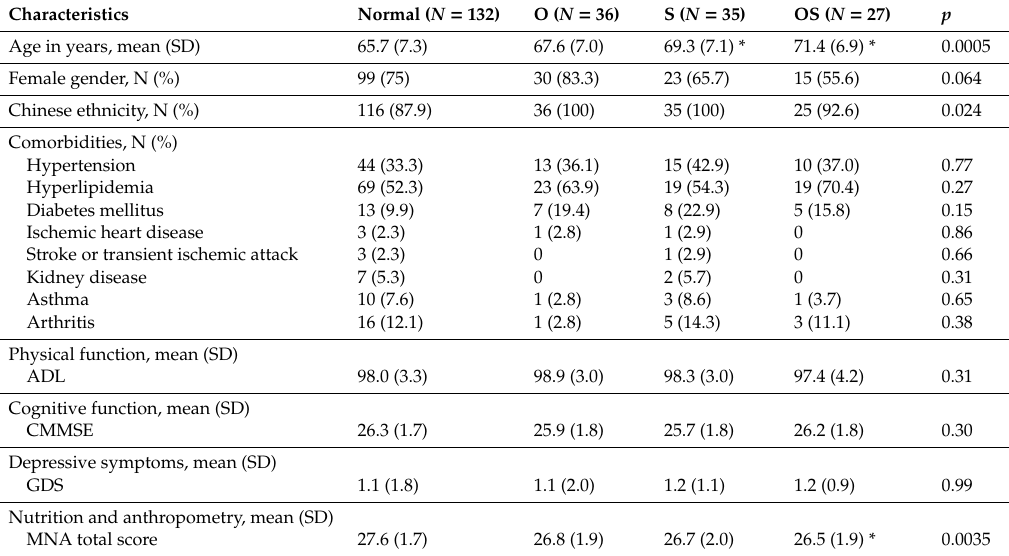
Table 1. Baseline characteristics, nutritional and frailty status.